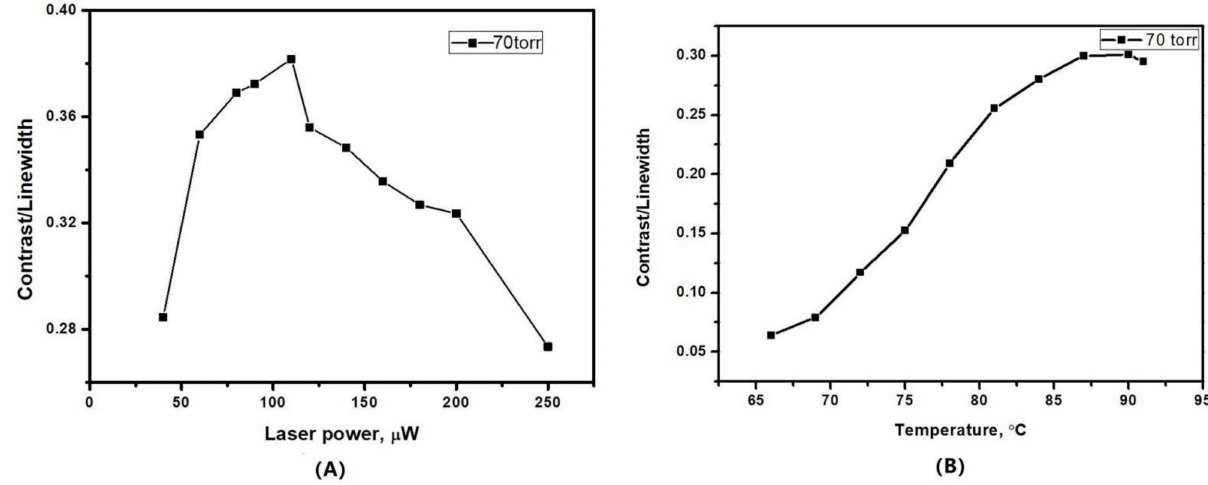
Figure 9. The ratio contrast/linewidth as a function of ( A ) laser power and ( B )